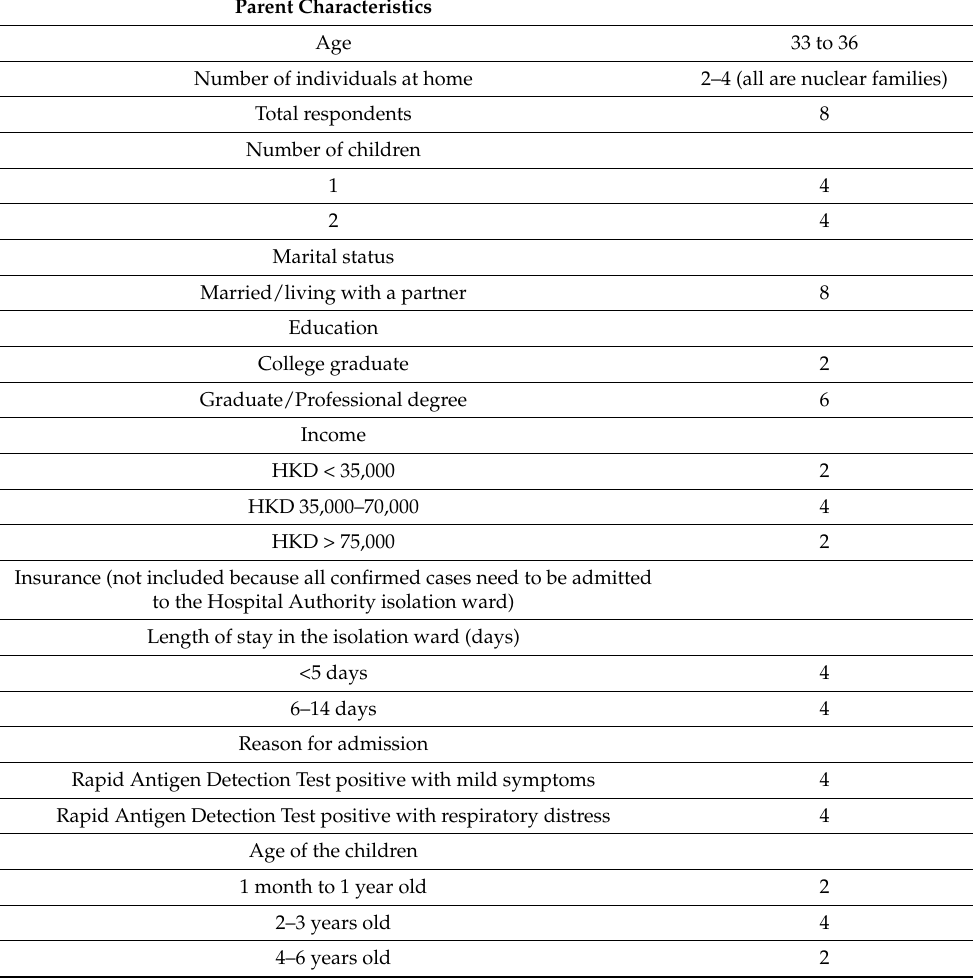
Table 2. Parent, children, and hospitalization